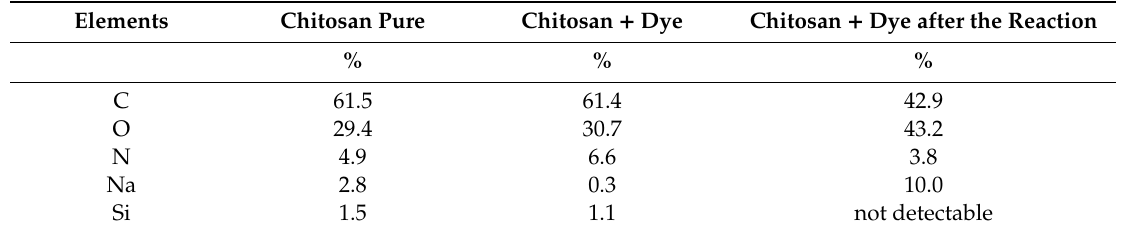
Table 2. Percentages of elements of analyzed carriers.